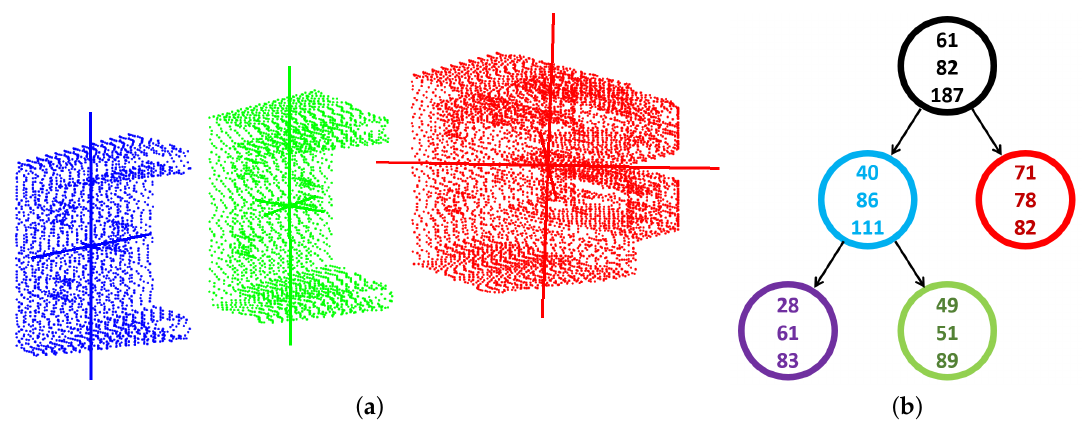
Figure 4. ( a ) Hierarchical PCA decomposition of the point cloud from Figure 2 and ( b ) the related tree, the vertices of which are labeled with the triples of